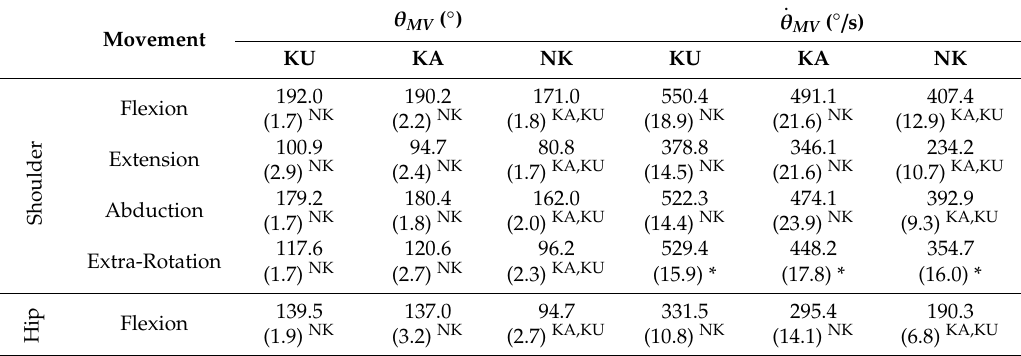
Table 2. Mean values (standard errors) for θ MV and performed at the maximum possible velocity for all the examined groups. KU, KA, and NK stand for kumite, kata, and non-karatekas group, respectively. Superscripts represent statistical di ff erences, with * indicating di ff erence among all groups.